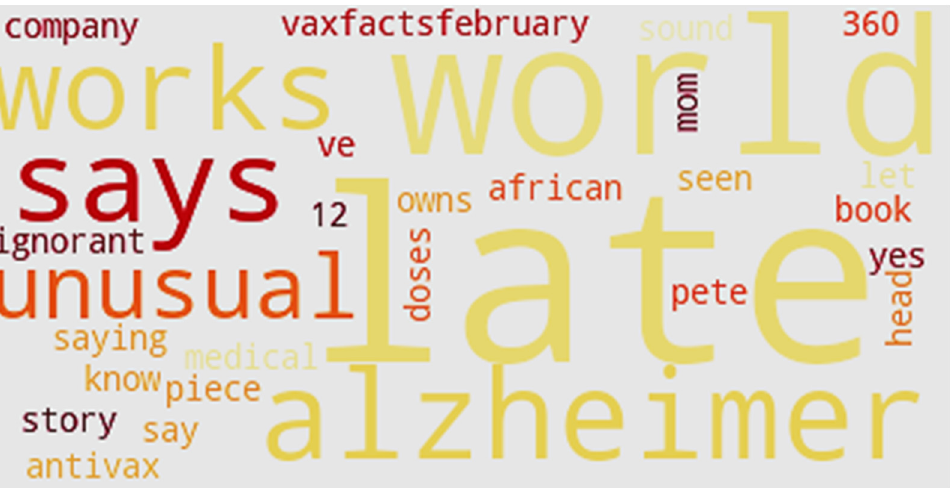
Figure 18. Word cloud of Cluster 3.